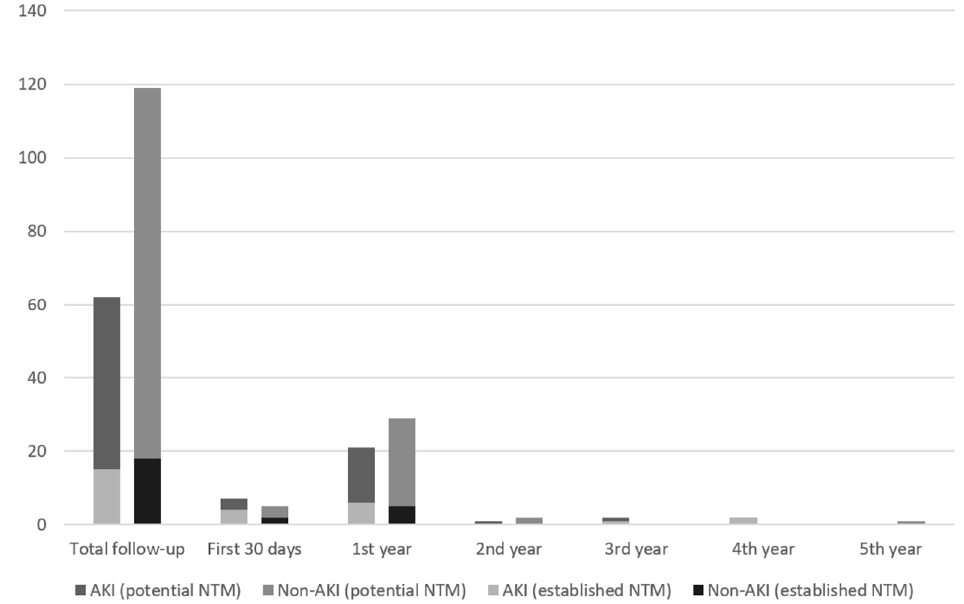
Figure 3. Percentages of AKI and non-AKI Patients Receiving ≥ 3 Nephrotoxic Medication Classes by Year Since PICU Discharge. Bar chart of proportions of AKI and Non-AKI patients who received ≥ 3 nephrotoxic medication prescriptions by year since PICU discharge. Numbers above bars represent the total number of participants with continuous follow-up at the time interval after discharge (denominator).